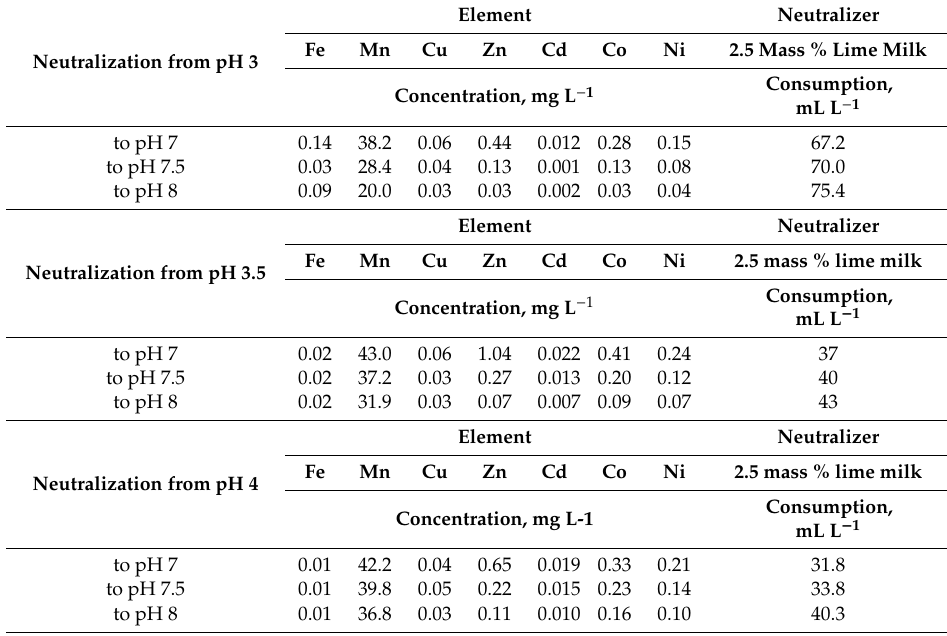
Table 4. Concentration of some elements after the second neutralization step of real AMD.